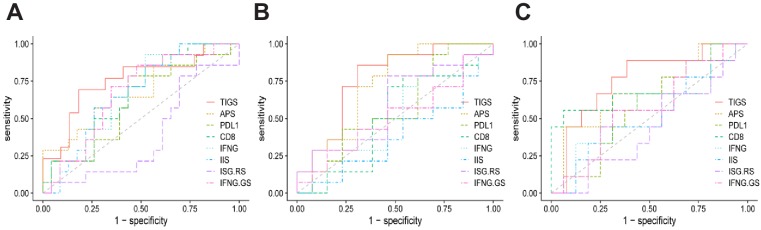
ROC curves for the performance of APS, CD8, IFNG, IIS, PDL1 and TIGS in predicting immunotherapy response in the Van Allen et al. (2015) melanoma dataset (A), the Hugo et al. (2016) melanoma dataset (B) and the Snyder et al. (2017) urothelial cancer dataset (C).